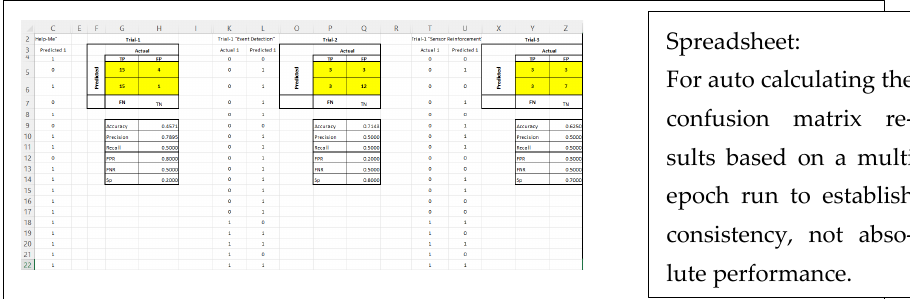
Figure 29. Test results—”event detection” trials.